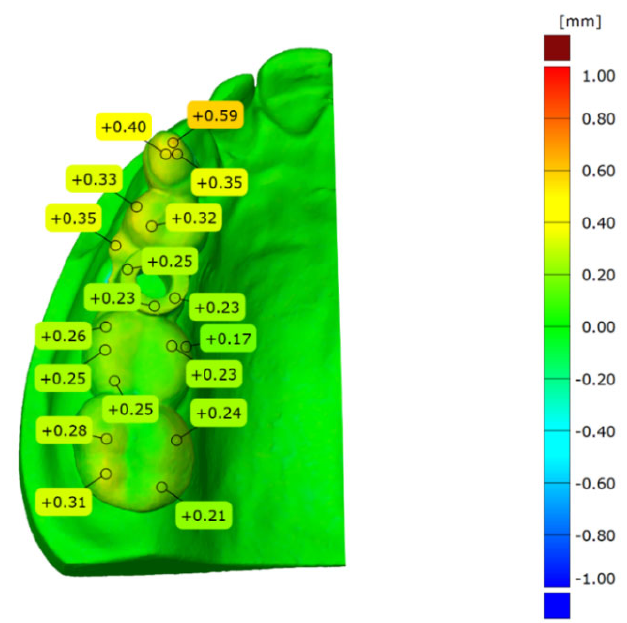
Figure 6. Total surface comparison between the actual placement and designed implant guide.